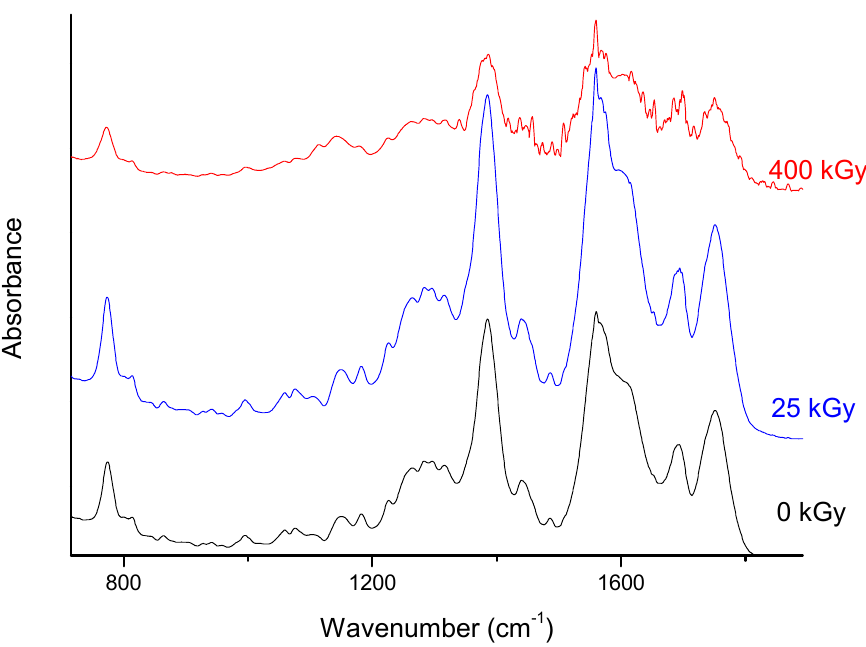
Figure 7. Fourier Transform Infrared (FT-IR) spectra of non-irradiated and irradiated ertapenem.